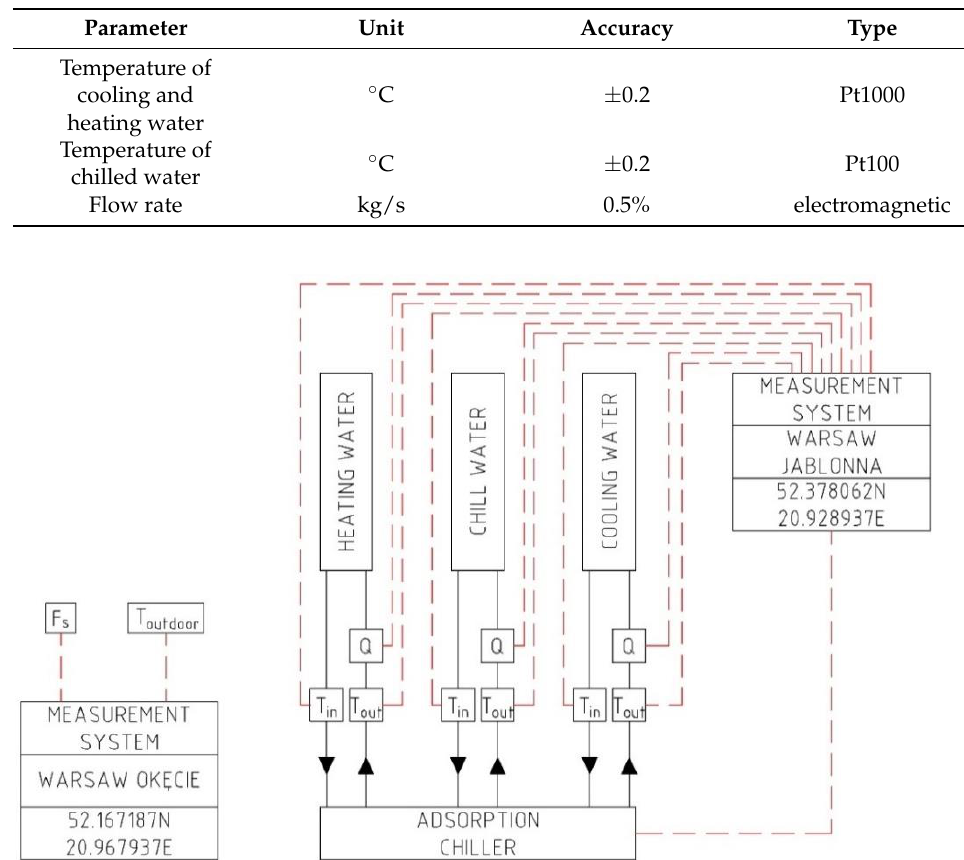
Figure 5. Flowchart of the measurement methodology: (F s ) solar radiation meter, (T outdoor ) outside temperature sensor, (Q) flow meter, (T in ) inlet temperature sensor, (T out ) outlet temperature sensor. Table 3. Technical data of the measuring instruments.